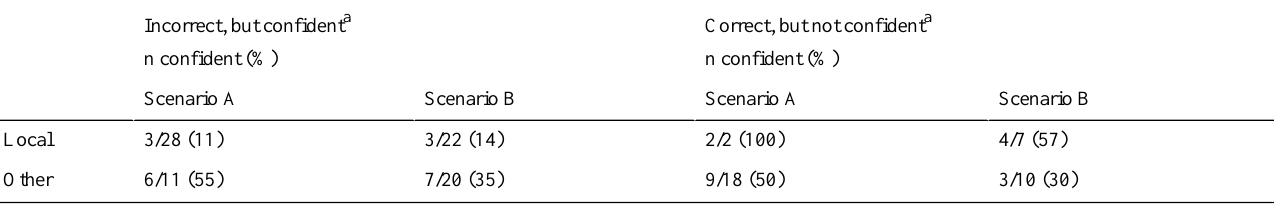
Table 3. Accuracy of and confidence in